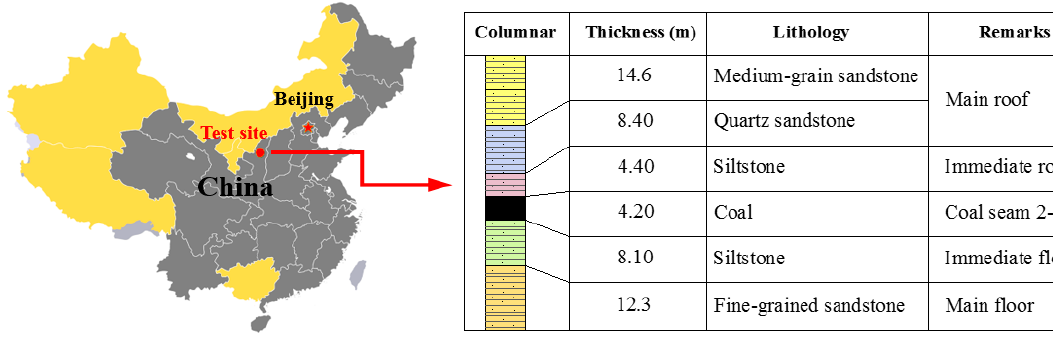
Figure 8. Lithology of the rock layers near the coal.